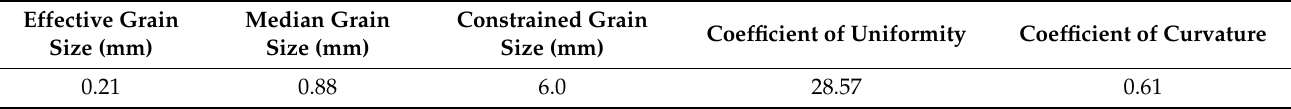
Figure 2. Grain size distribution curve.